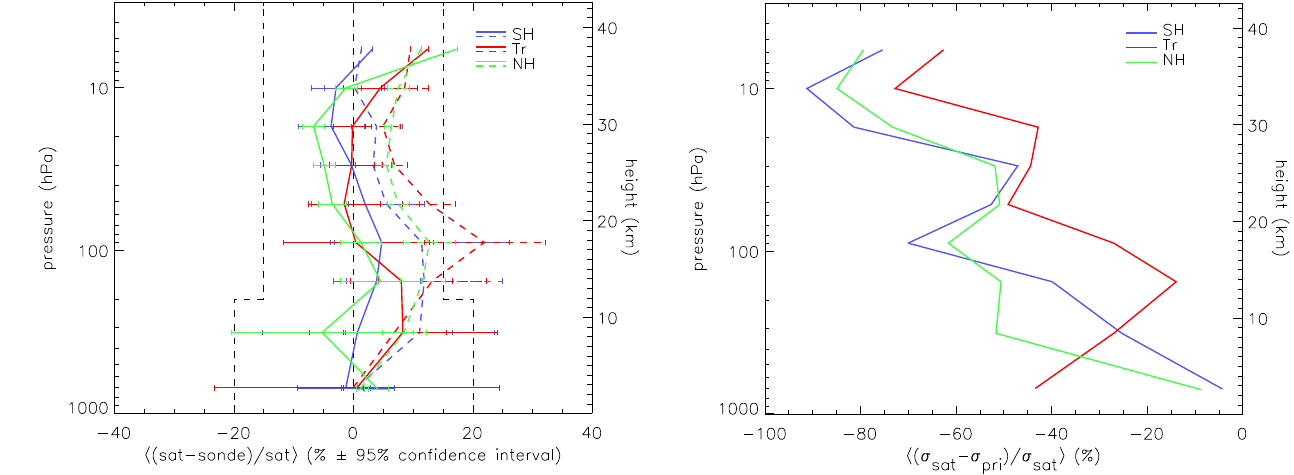
Fig. 4. Mean of the relative error differences per latitude band for GOME retrievals and a priori. The blue line gives the result for the Southern Hemisphere (SH), red for the tropics (Tr) and green for the Northern Hemisphere